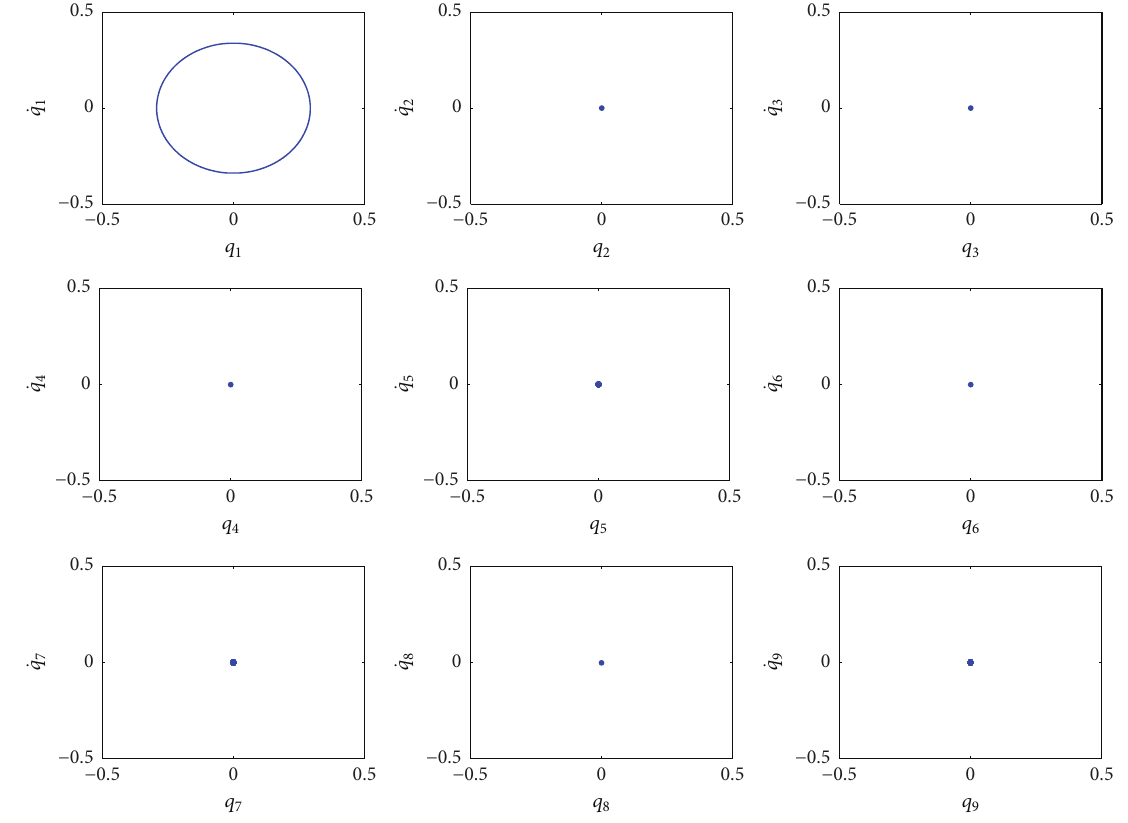
Figure 8: Two-dimensional projections of phase portraits onto the (𝑞 𝑟 , ̇𝑞 𝑟 ) plane, 𝑞 𝑟 (0) = 0.1𝛿 1𝑟